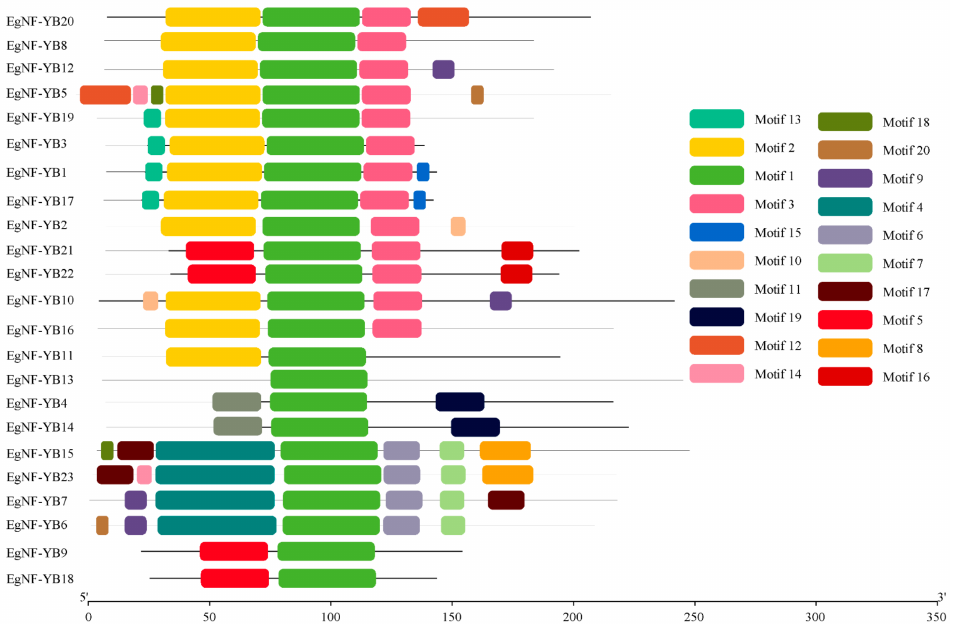
Figure 2. The conserved motifs of EgNF-YB genes. The conserved motifs in the EgNF-YB proteins were identified with MEME software. Black lines denote the non-conserved sequences, and each motif is indicated by a colored box numbered on the right. The length of motifs in each protein is presented proportionally.